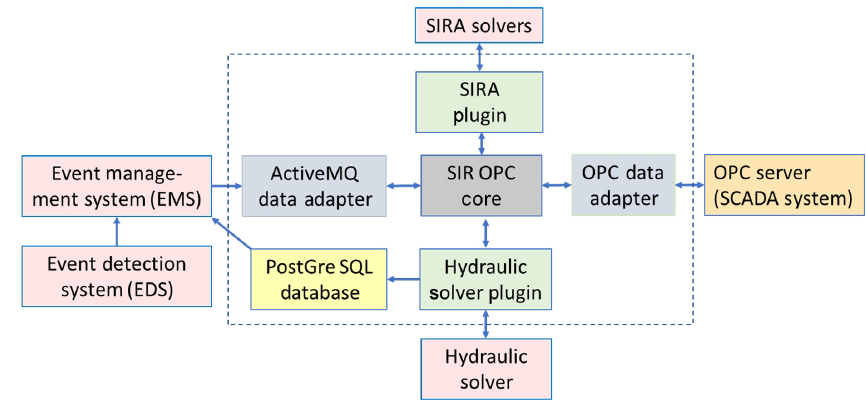
Figure 1. System architecture of SI integration within the SAFEWATER event management system.